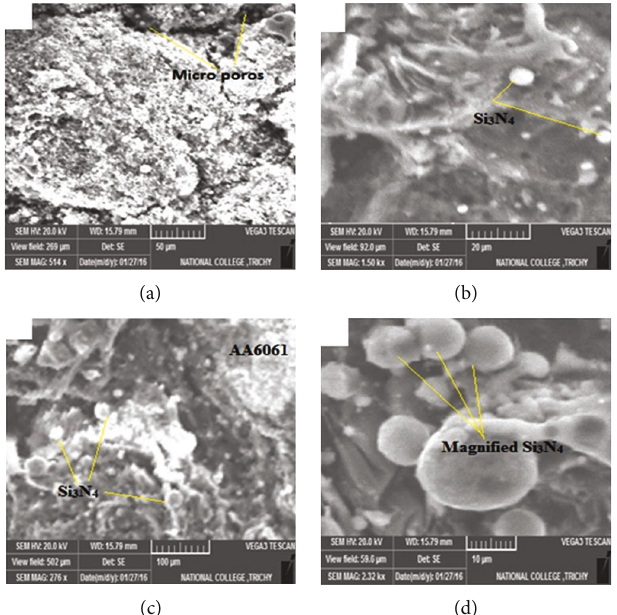
Figure 4: SEM image of AA6061 alloy nanocomposites (a) AA6061 alloy, (b) AA6061/4 wt% Si AA6061/12 wt% Si